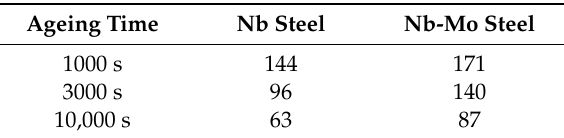
Table 2. Calculated precipitation hardening (MPa) by Orowan mechanism for the Nb and Nb-Mo steels after isothermal holding at 900 ◦